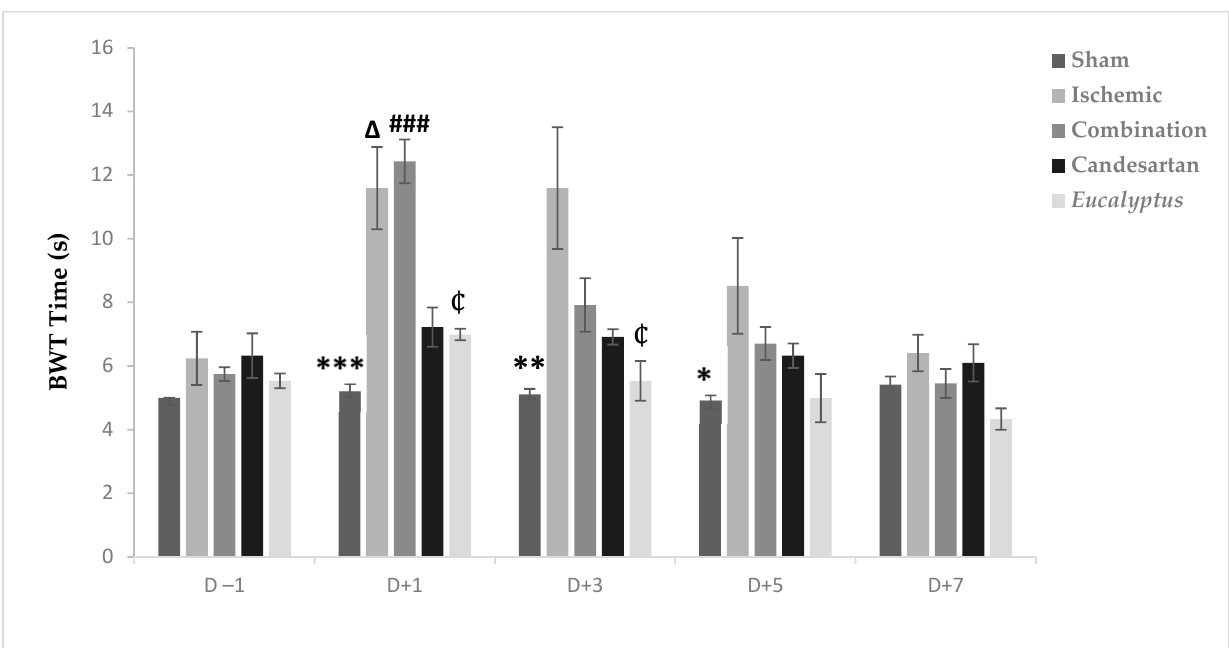
Figure 1. Beam balance test (BBT) scores. BBT scores on days (D) (–1, +1, +3, +5, +7) for the different experimental groups. Sham (n = 6), Ischemic (n = 11), Ischemic treated with a combination of Can- desartan and Eucalyptus (n = 10), Ischemic treated with Candesartan (n = 5), and Ischemic treated with Eucalyptus (n = 5). * p < 0.05; *** p < 0.001 for a significant difference between Ischemic and Sham; $$ p < 0.01; $$$ p < 0.01 for a significant difference between Ischemic and Ischemic treated with a combination of Candesartan and Eucalyptus ; ∆∆∆ p < 0.001 for a significant difference be- tween Ischemic and Ischemic treated with Candesartan only; ₵₵ p < 0.01 for a significant differ- ence between Ischemic and Ischemic treated with Eucalyptus only; ₵₵₵ p < 0.01 for a significant difference between Ischemic and Ischemic treated with Eucalyptus only.